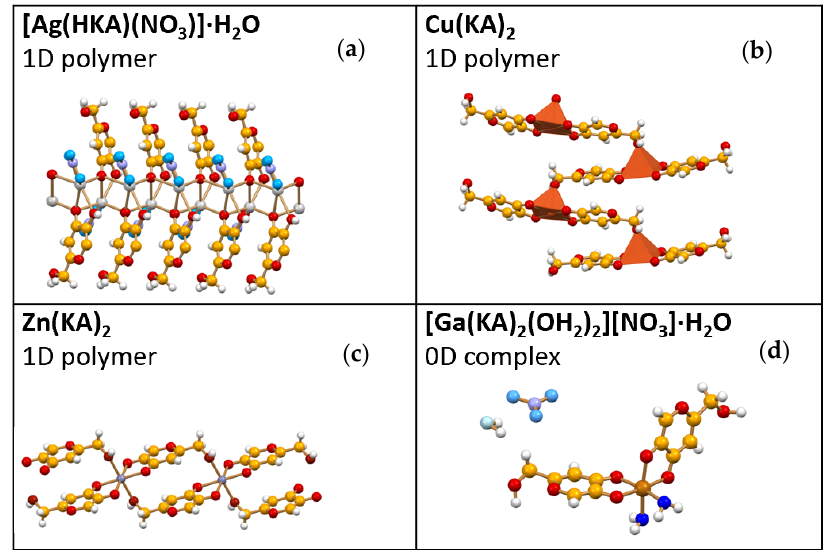
Scheme 2. The products of the reactions of kojic acid with ( a ) silver(I), ( b ) copper(II), ( c ) zinc(II), and ( d ) gallium(III) salts.